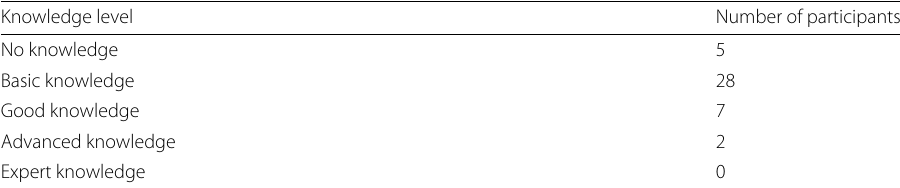
Table 4 Distribution of different knowledge levels about smart home